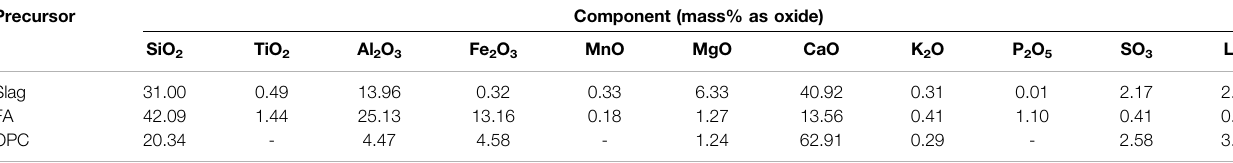
TABLE 1 | Chemical compositions of slag, FA, and OPC determined by X-ray fl uorescence. LOI is the loss on ignition at 1,000 ° C. Precursor